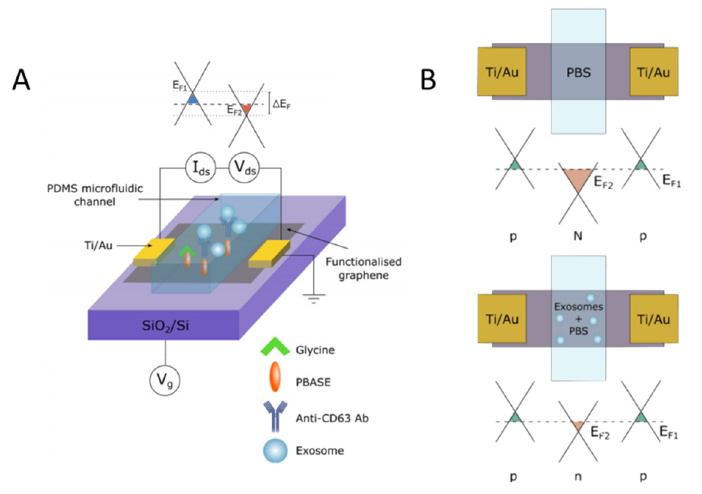
Figure 5. Antibody surface functionalization for exosome capture and electric biosensing with graphene. ( A ) Schematic of gFET mechanism for detection of negatively charged exosomes once captured by the graphene surface through surface functionalization with a chemical linker and anti-CD63 antibody. ( B ) Schematic of negative charge from exosome surface potential leading to positive charge accumulation in the graphene surface, showing Fermi energy of graphene surface. Reprinted with permission from Copyright Clearance (2019) Springer Nature Scientific Reports.